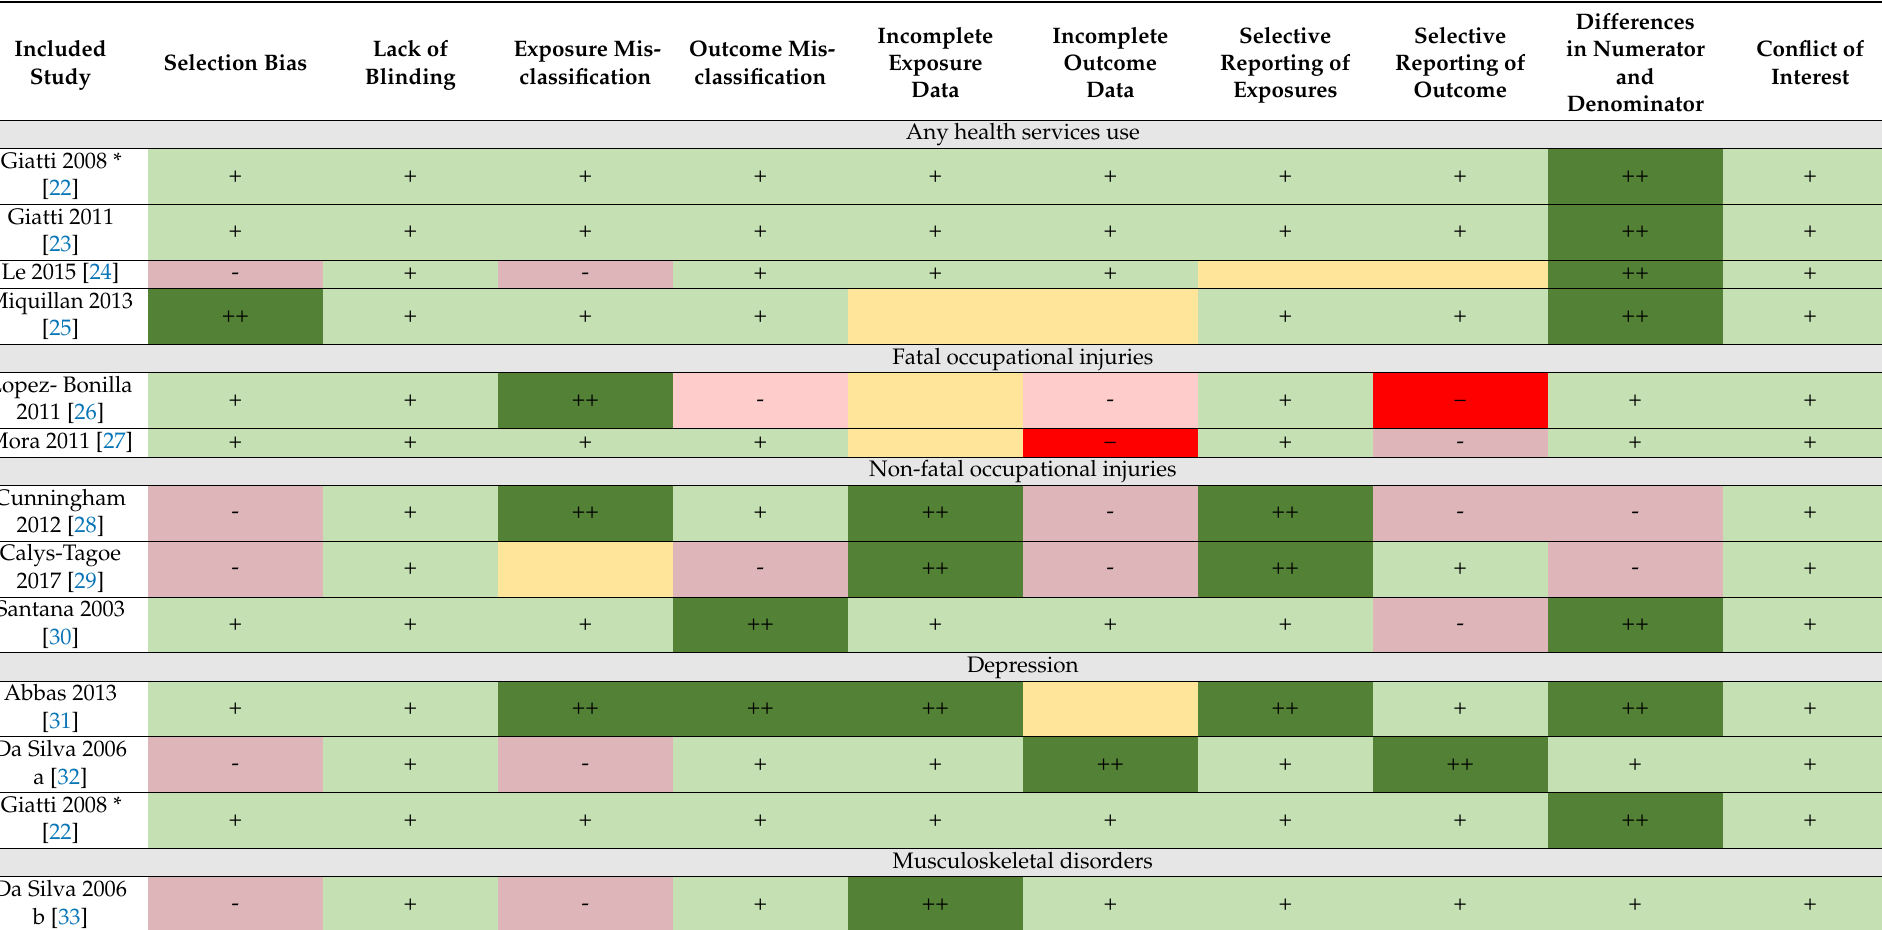
Table 3. Summary of the risk of